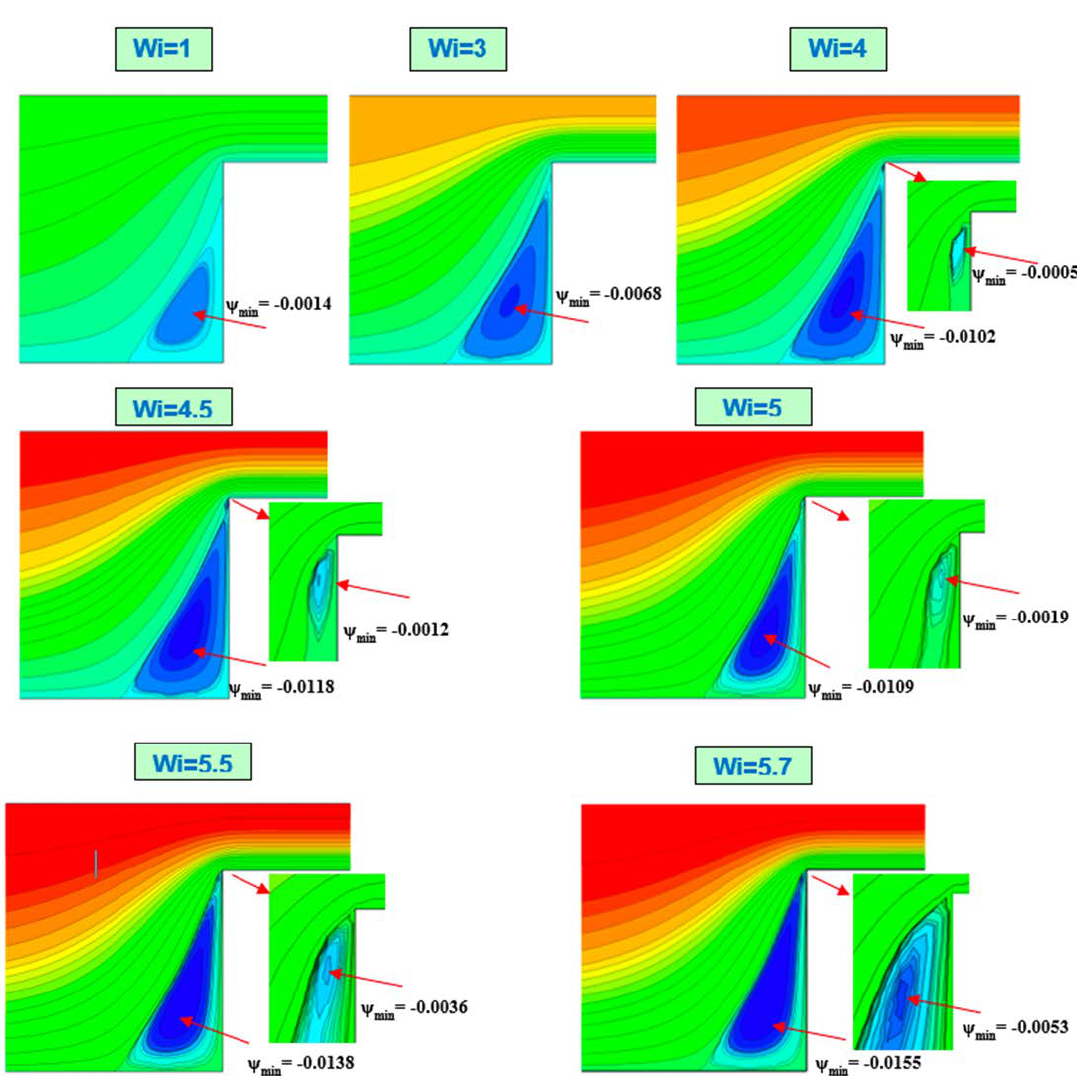
Figure 14. Vortex-intensity ( − Ψ min ); α aspect = 4; swIM [ L = 12, β = 0.7, λ D = 0.1]. Seeking lip-vortices through λ D -rise under β = {0.8, 0.7} and L = 12 . Following on from the